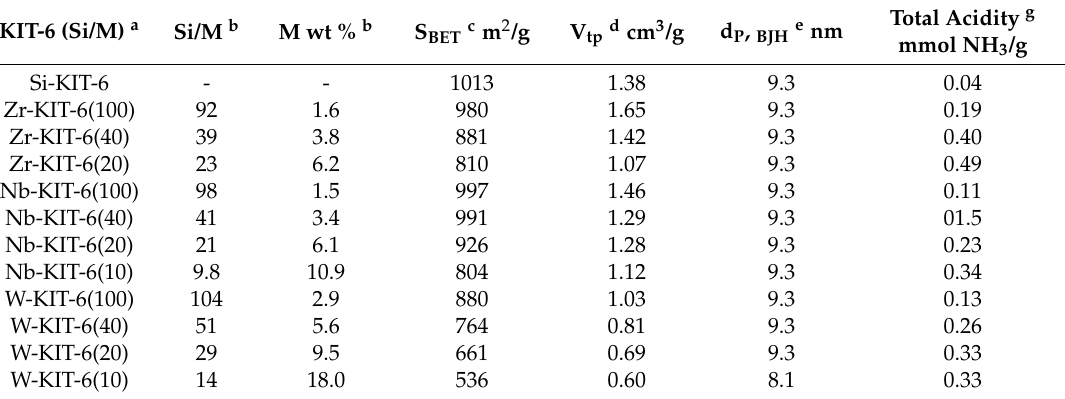
model, g From ammonia TPD measurements.